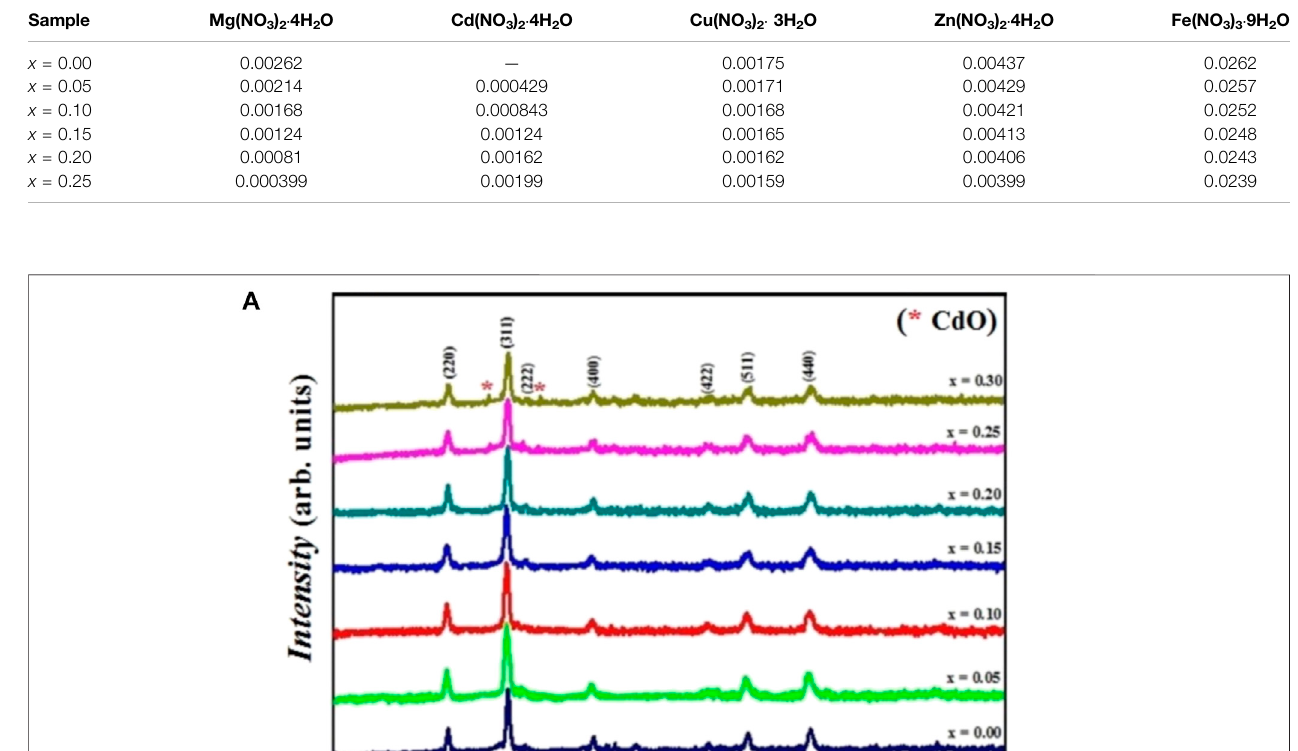
TABLE 1 | Moles of the metal nitrates to prepare the Mg 0.3- x Cd x Cu 0.2 Zn 0.5 Fe 2 O 4 .